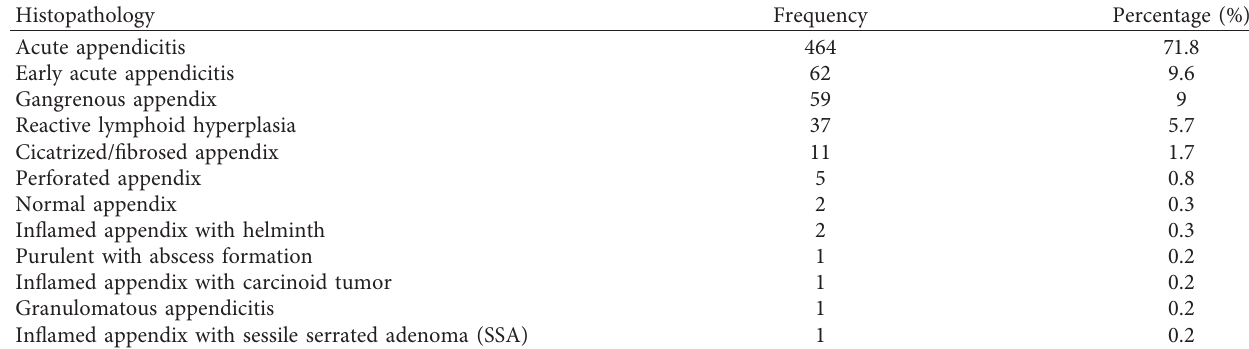
Table 2: Histopathologic classification.